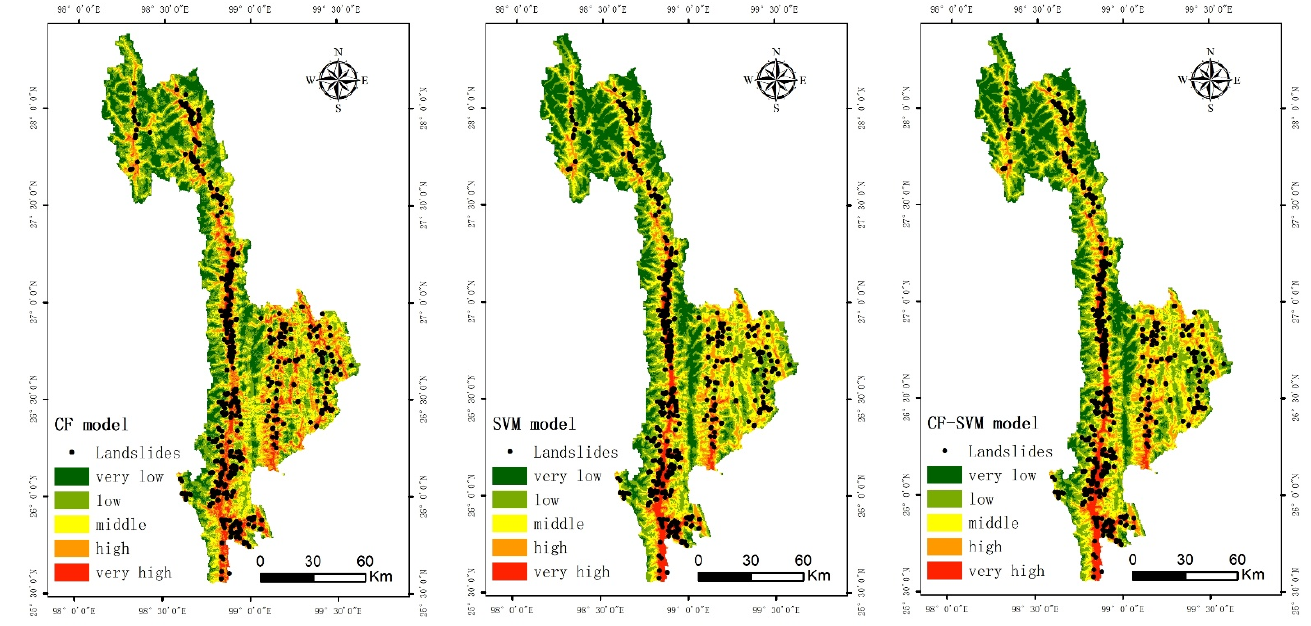
Figure 6. Evaluation grade of landslide susceptibility of each model.